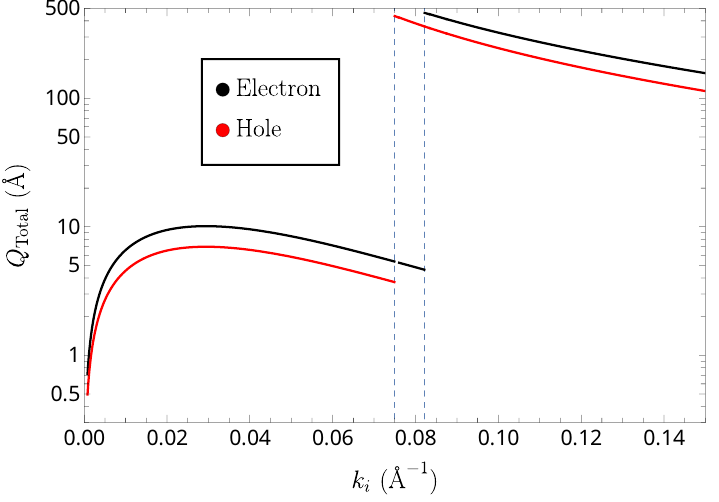
Figure 3. Total cross section for electron–exciton (black) and hole–exciton (red) scattering in hBN encapsulated in fused quartz as a function of the initial relative wave vector. Vertical dashed lines represent the electron–exciton and hole–exciton scattering thresholds for the 1 s → 2 p transition, − 1 − 1 located at k min, e − = 0.0822Å and k min, h = 0.0749Å